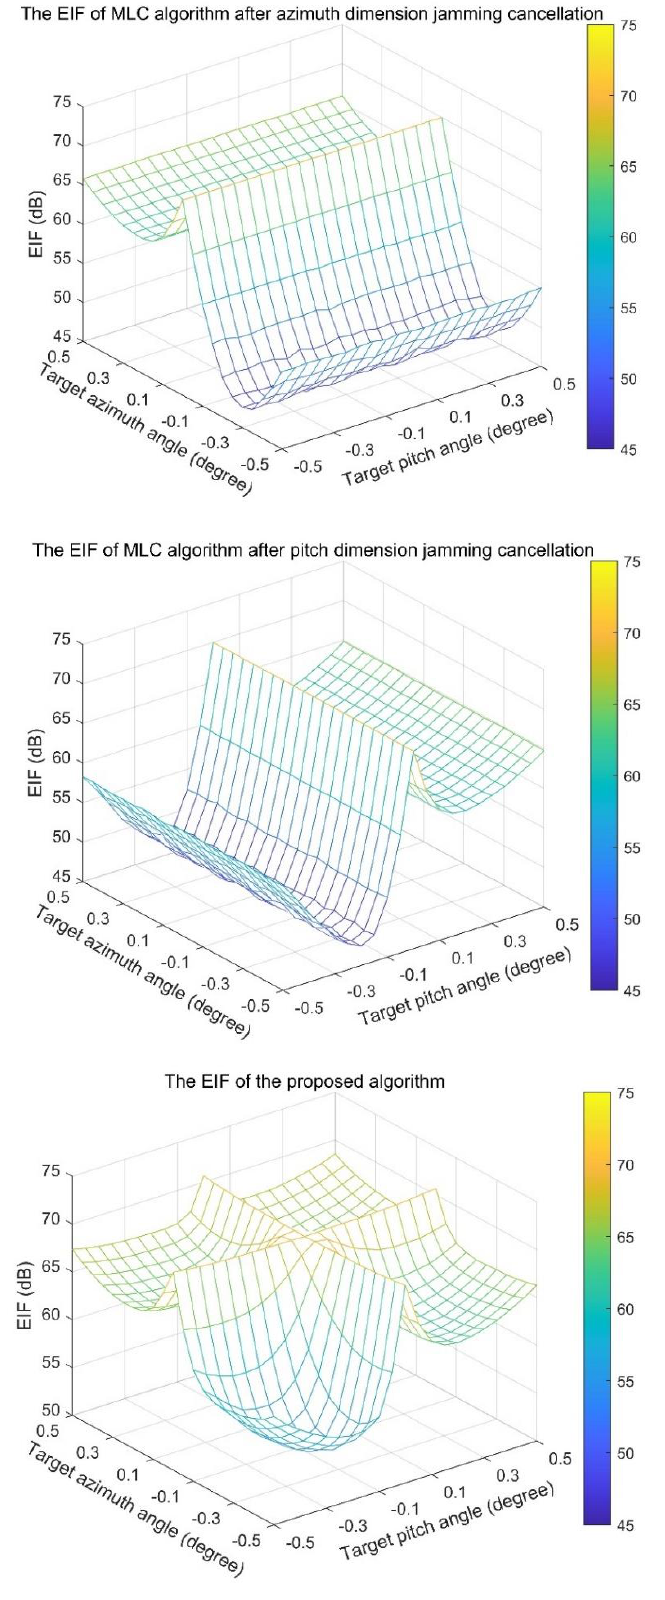
Figure 3. The EIF of two algorithms when the SJR is − 50 dB.